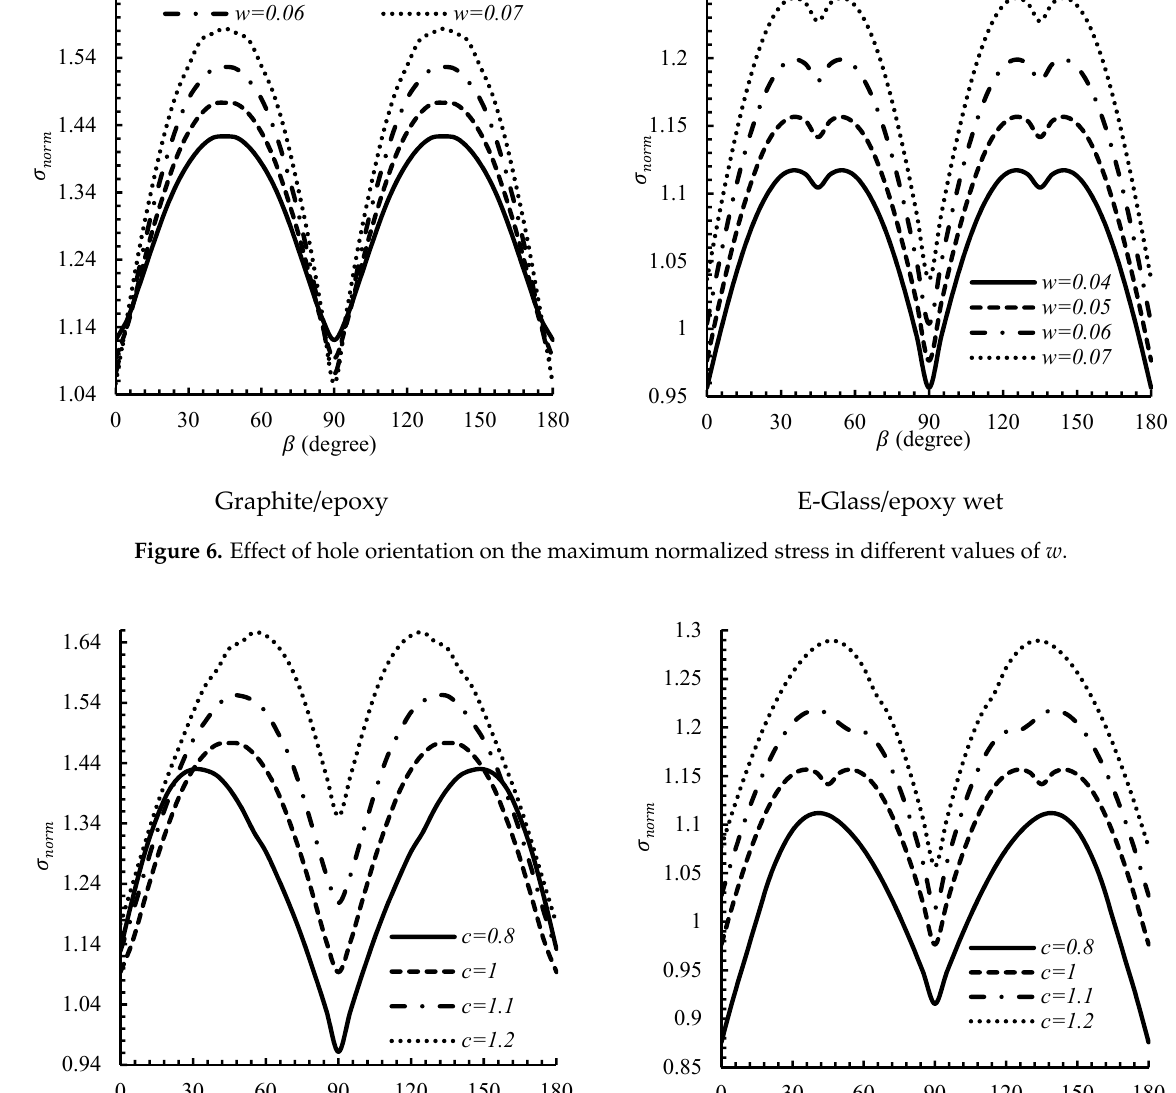
Figure 6. Effect of hole orientation on the maximum normalized stress in different values of w.